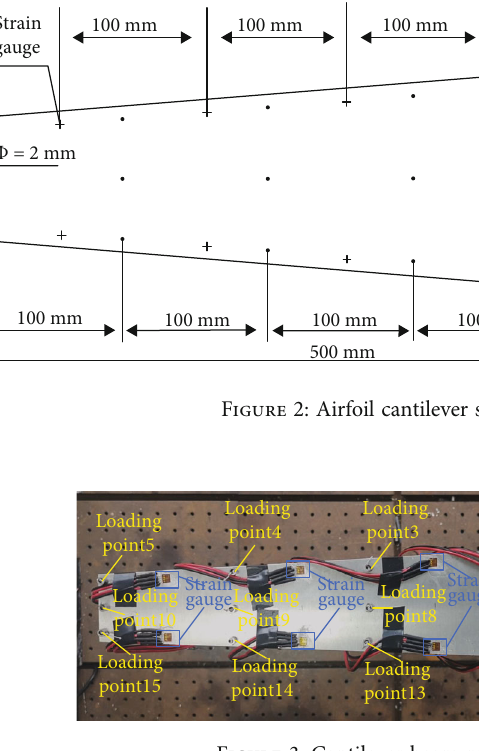
Figure 3: Cantilever beam model with